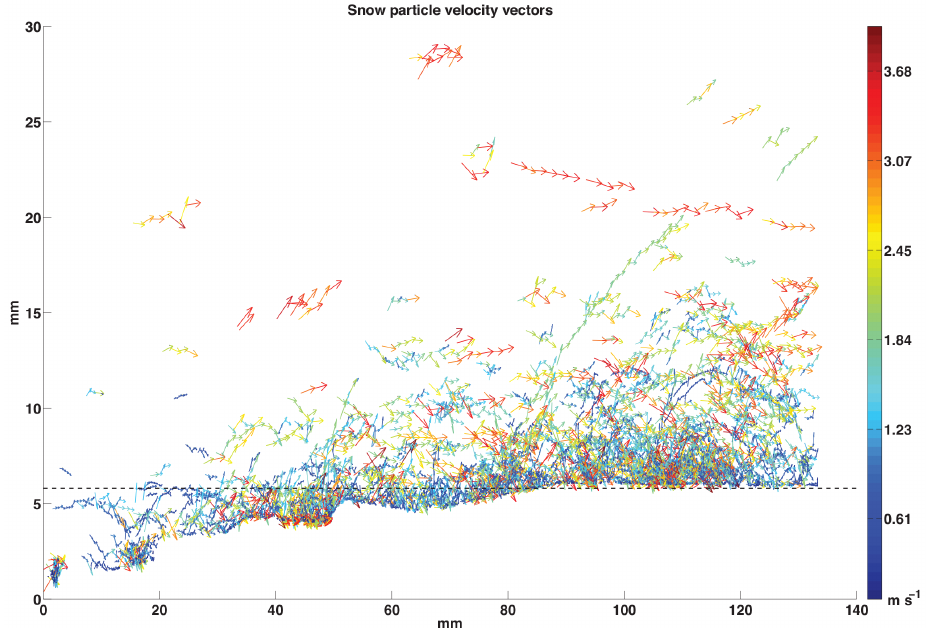
Figure 2. Sparse snow particle velocity vector field during 1s of recording on 23 March, vector colors scaled according to total particle speed. The dashed line shows reference below which particles are influenced by